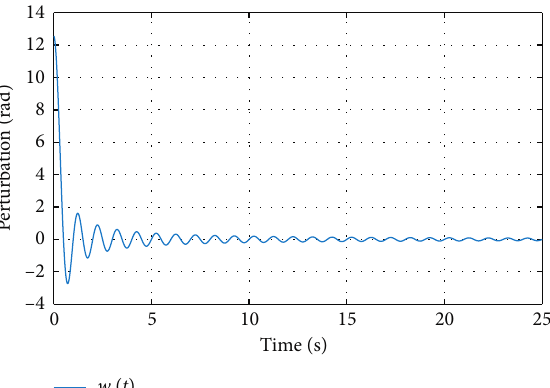
Figure 7: DIP response with perturbation.